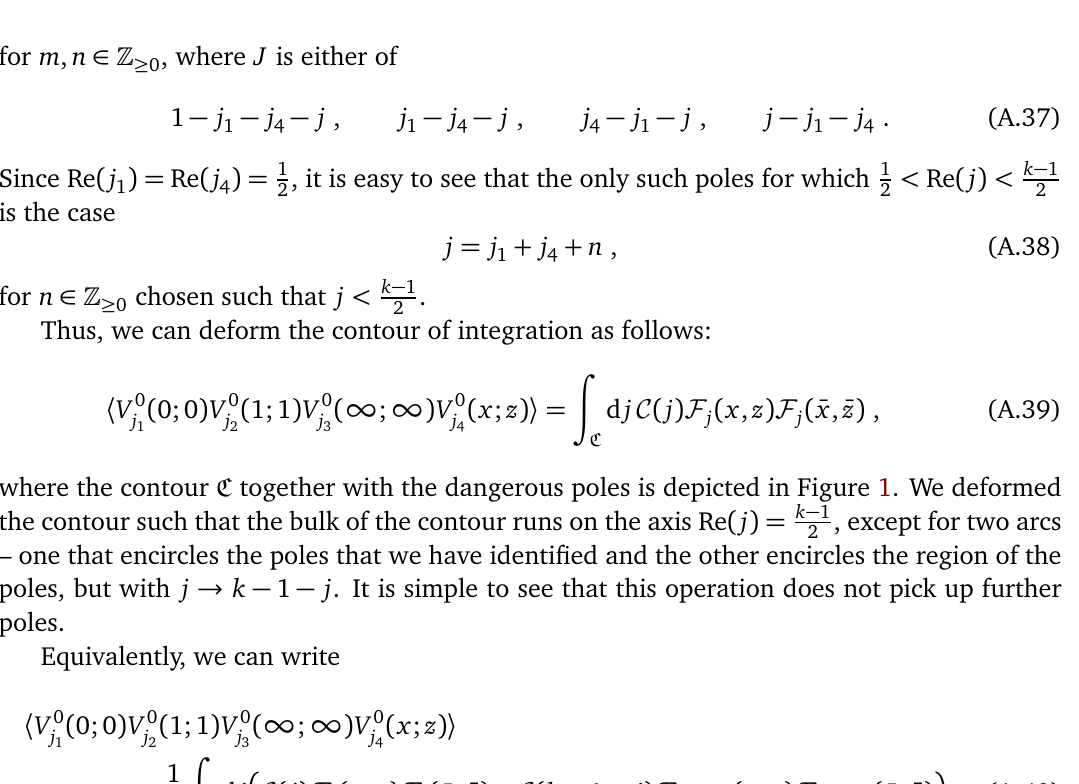
Figure 1: The deformed contour C . The green poles are not present in the original integral (A.39), but are added in after we symmetrise the integrand in j → k − 1 − j in eq.